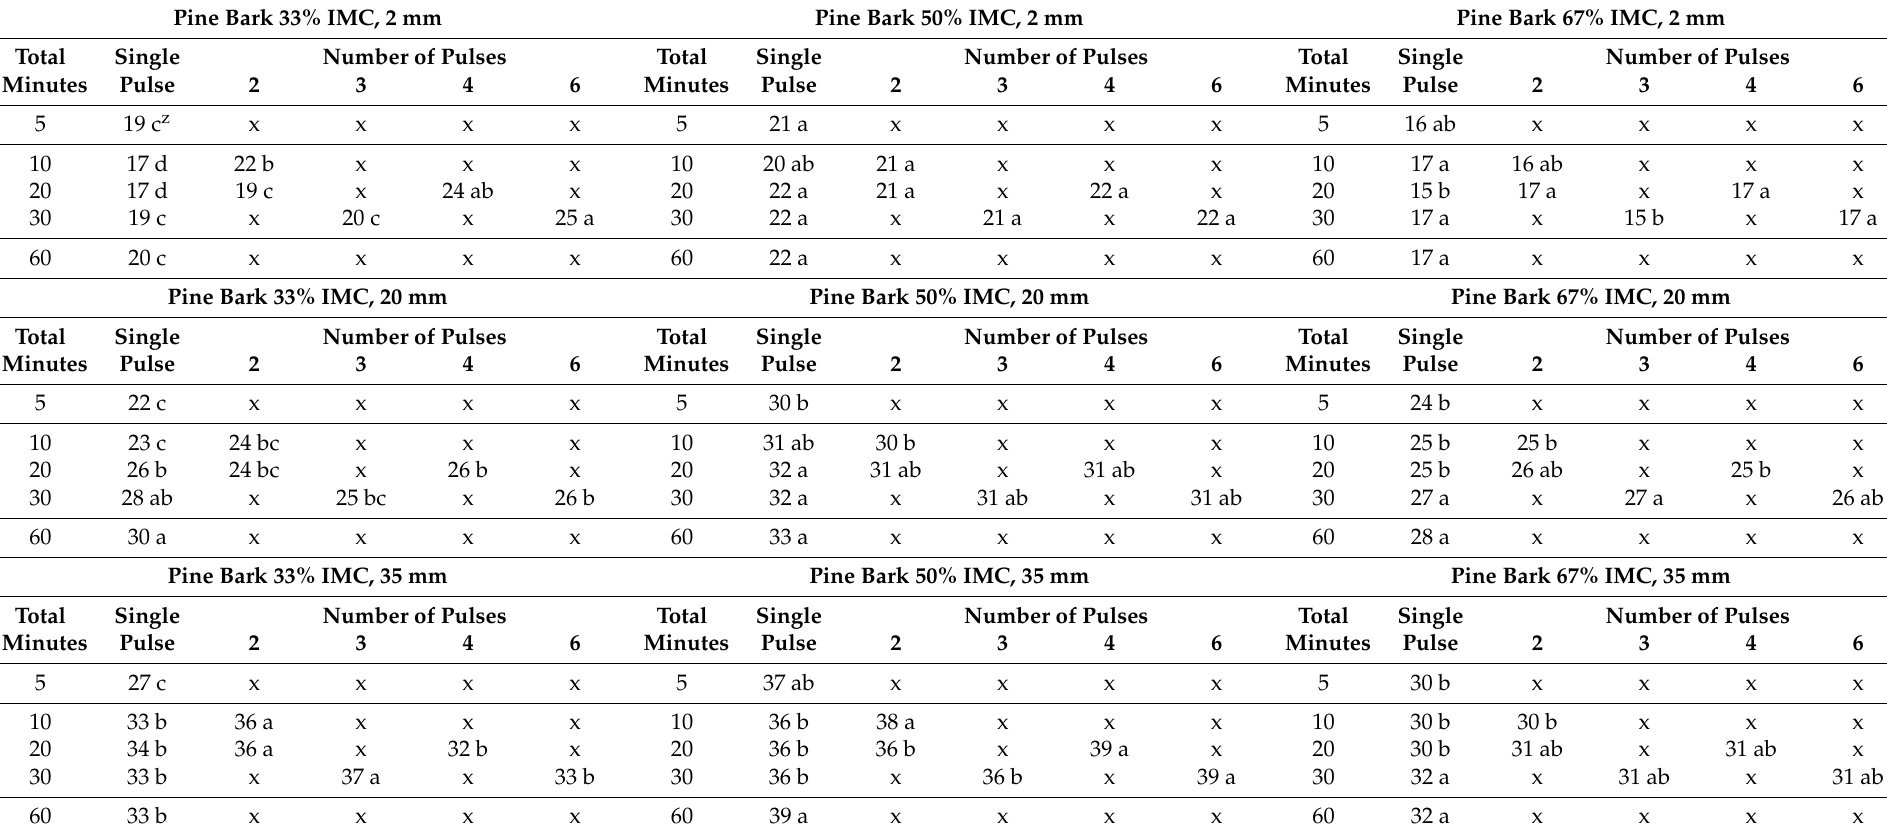
Table 4. Average water capture (% VWC) of pine bark at three initial moisture contents (IMC) of 33%, 50%, and 67%, three irrigation water levels of 2 mm, 20 mm, and 35 mm, and at five irrigation pulse durations (by event total) per water